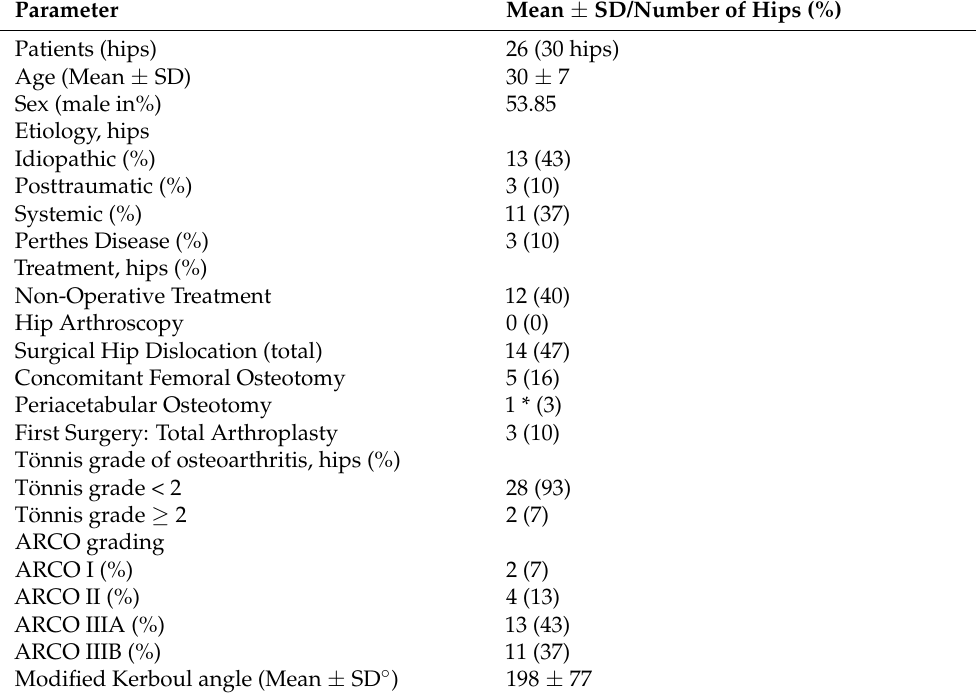
Table 1. Demography and radiography of the study